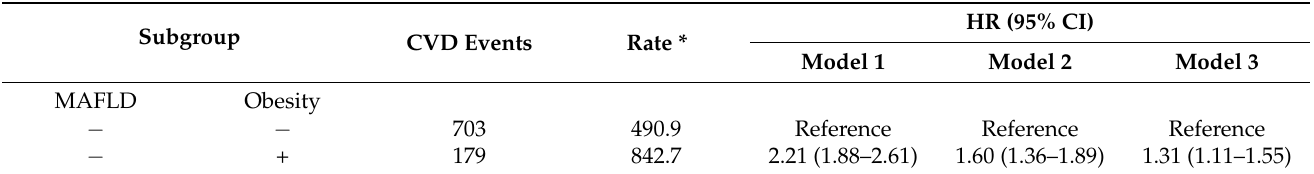
Table 4. Subgroup analysis according to the presence of metabolic dysfunction-associated fatty liver disease and/or obesity, dyslipidaemia,